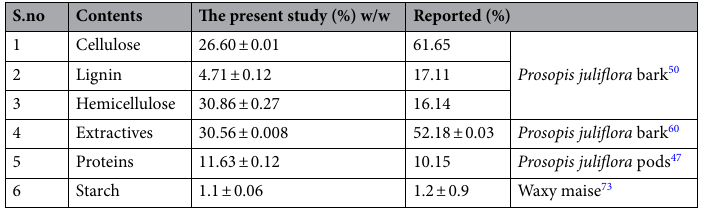
Table 4. Biochemical analysis of Pj